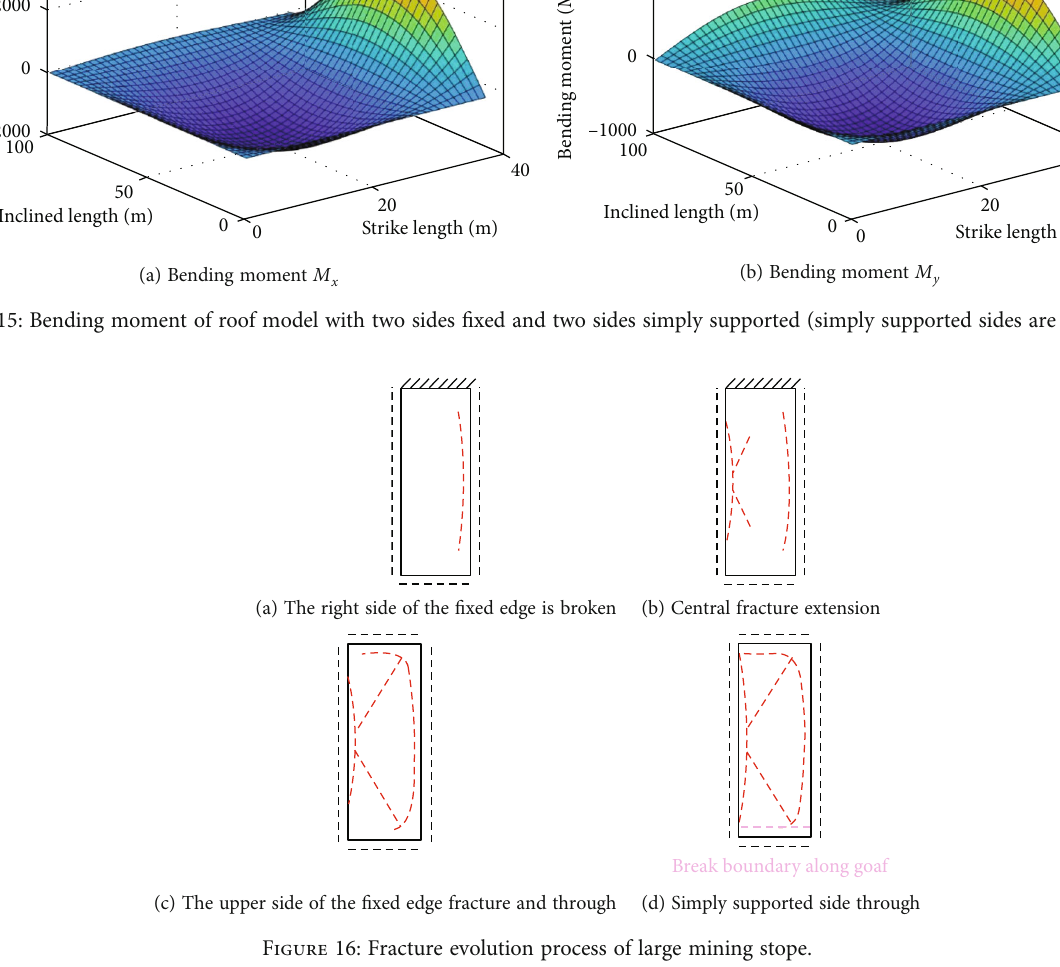
Figure 16: Fracture evolution process of large mining